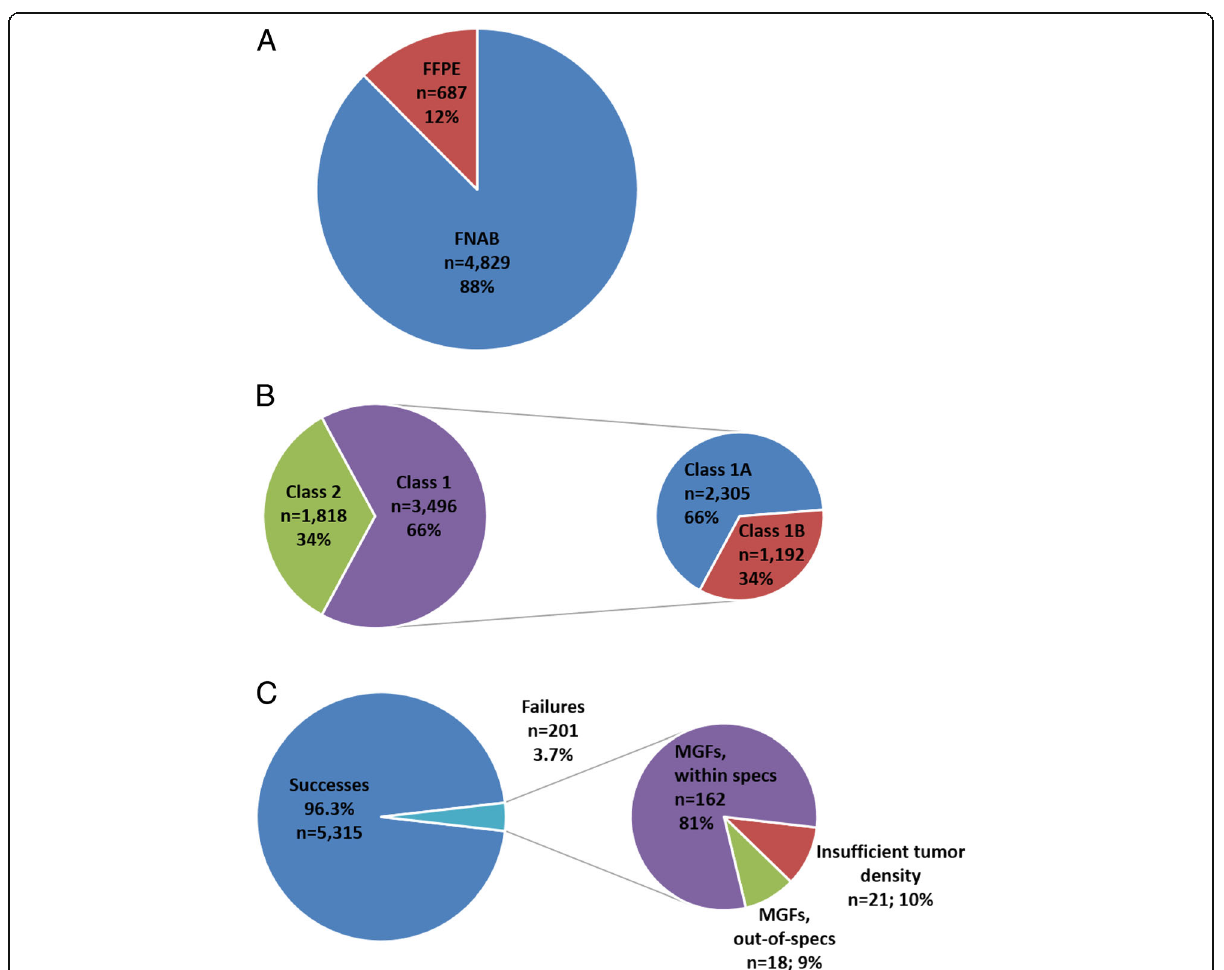
Fig. 4 Clinical experience with DecisionDx-UM testing. a Proportions of tissue type received for testing. b Proportions of Class 1A, 1B, and 2 results in clinical setting from January 2010-May 2016. c Technical success of DecisionDx-UM testing and proportions of technical failures due to multi-gene failures, out-of-specification samples, and insufficient tumor density